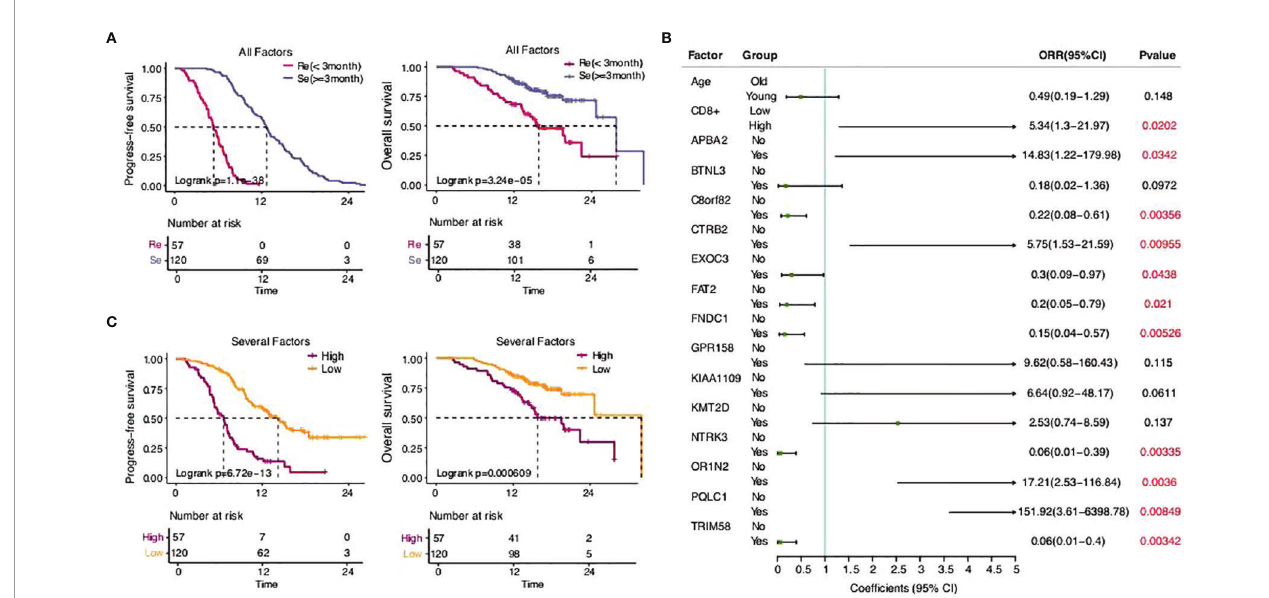
FIGURE 6 | The predictive model of drug resistance of SCLC. (A) Statistical analysis of the two groups. (B) Sixteen eigenvalues got selected through the stepwise regression process with resistance as the target variable. (C) Statistical analysis of the high-risk group and the low-risk